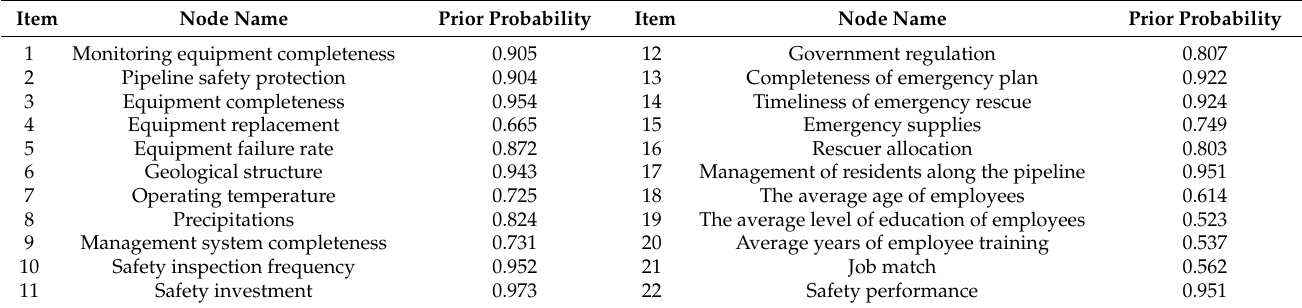
Table 6. Posteriori probability of pipeline third-party damage related nodes.